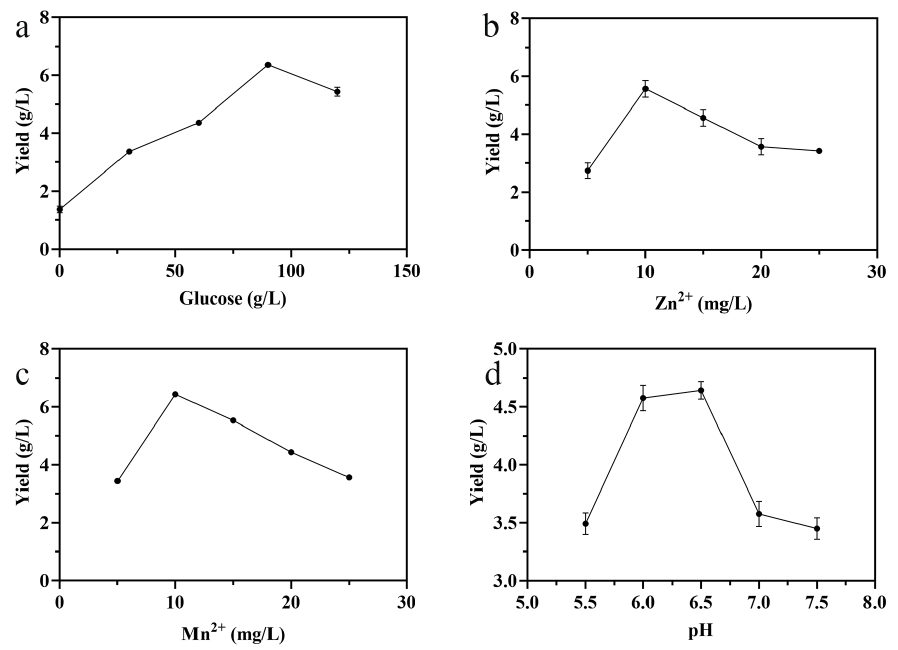
Figure 1. Effects of different concentrations of glucose ( a ), Zn 2+ ( b ), Mn 2+ ( c ), and pH ( d ) on the production of LSEP. Table 1. Process variables and their ranges of BBD.